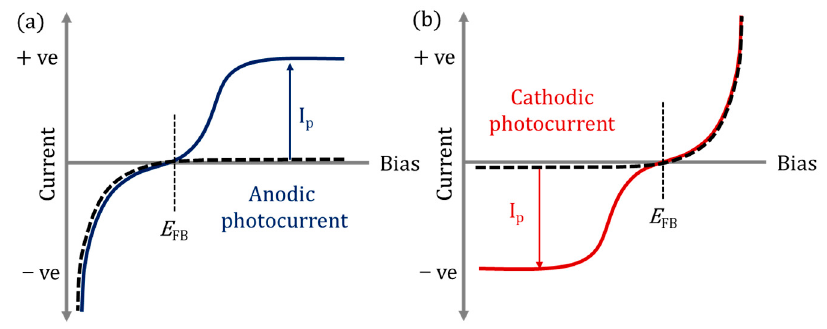
Figure 2. ( a ) Anodic photocurrent (I p ) response, ( b ) cathodic photocurrent (I p ) response; solid lines under irradiation; dashed lines in dark; E FB flat band potential.